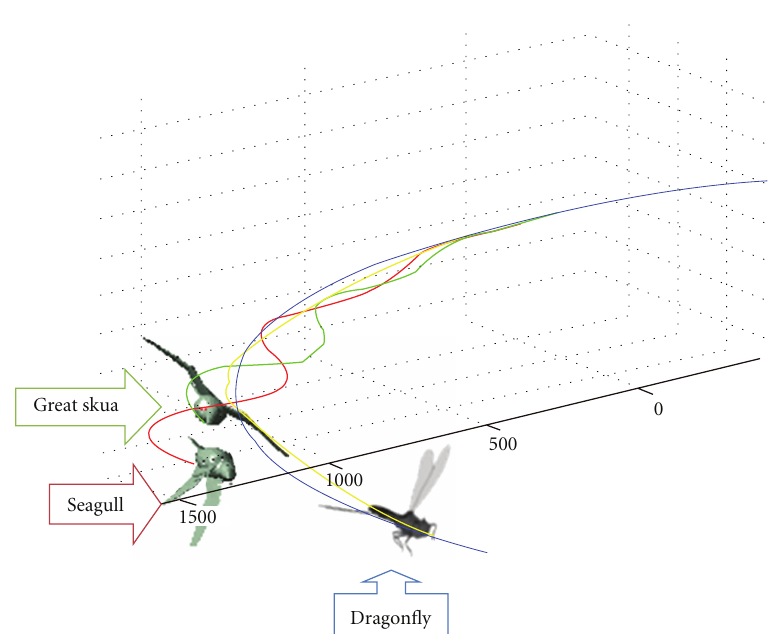
Figure 3: Chart obtained through the developed simulator that shows the di ff erence between the trajectory accomplished by a great skua (very large bird), a seagull (large bird) and a dragonfly. The stability of this last one when compared to the others is